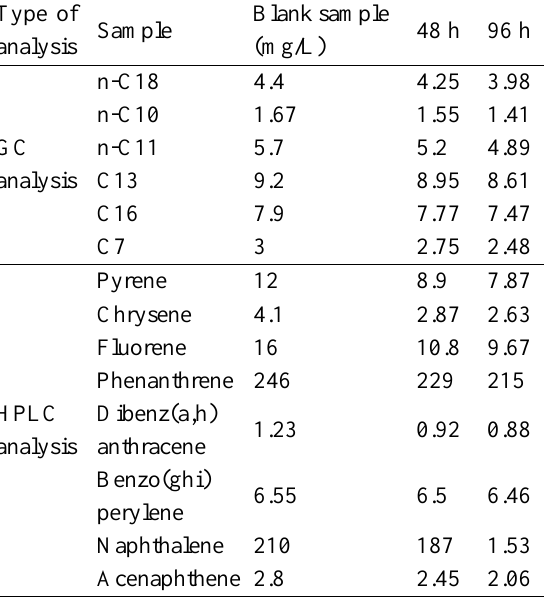
Table 2. Chemical analysis of samples by GC and HPLC in %1